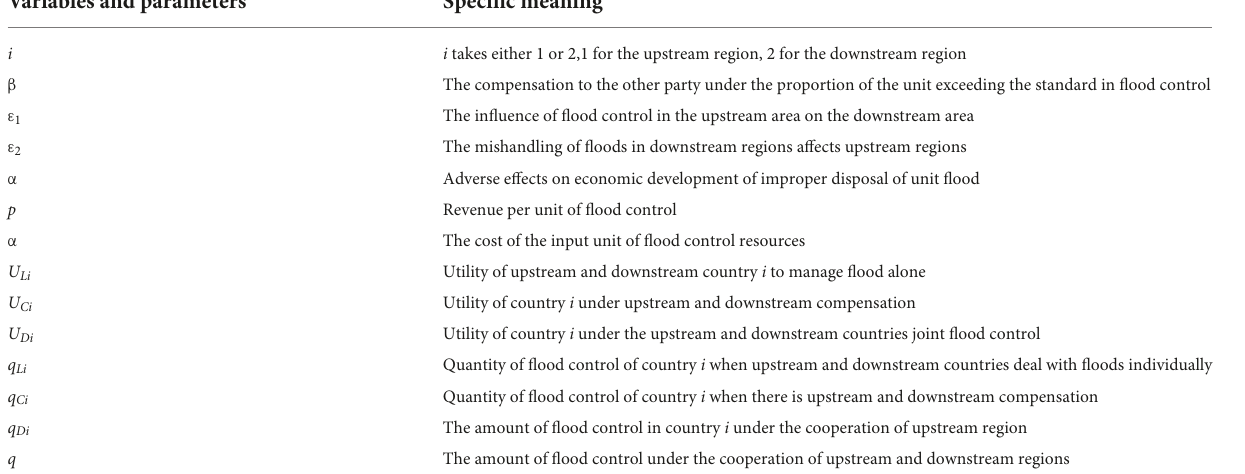
TABLE 1 The main variables and